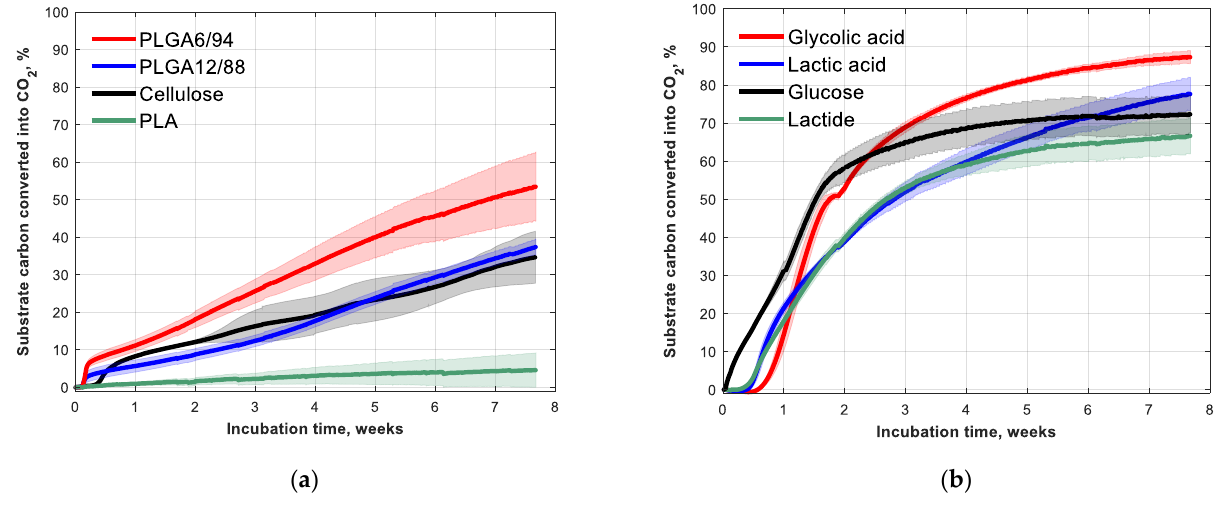
Figure 3. Fifty-three-day biodegradation curves of ( a ) PLA, PLGA12/88, PLGA6/94 and cellulose (references) and ( b ) glycolic acid, lactic acid, lactide and glucose (building blocks) with approximately 5 mg (substrate) carbon g −1 dry soil at 25 °C. Mean biodegradation (lines) were plotted. The shaded area represents the standard deviation (calculated per point) of at least three replicates, except for glucose, in which case it represents the range of the duplicates.